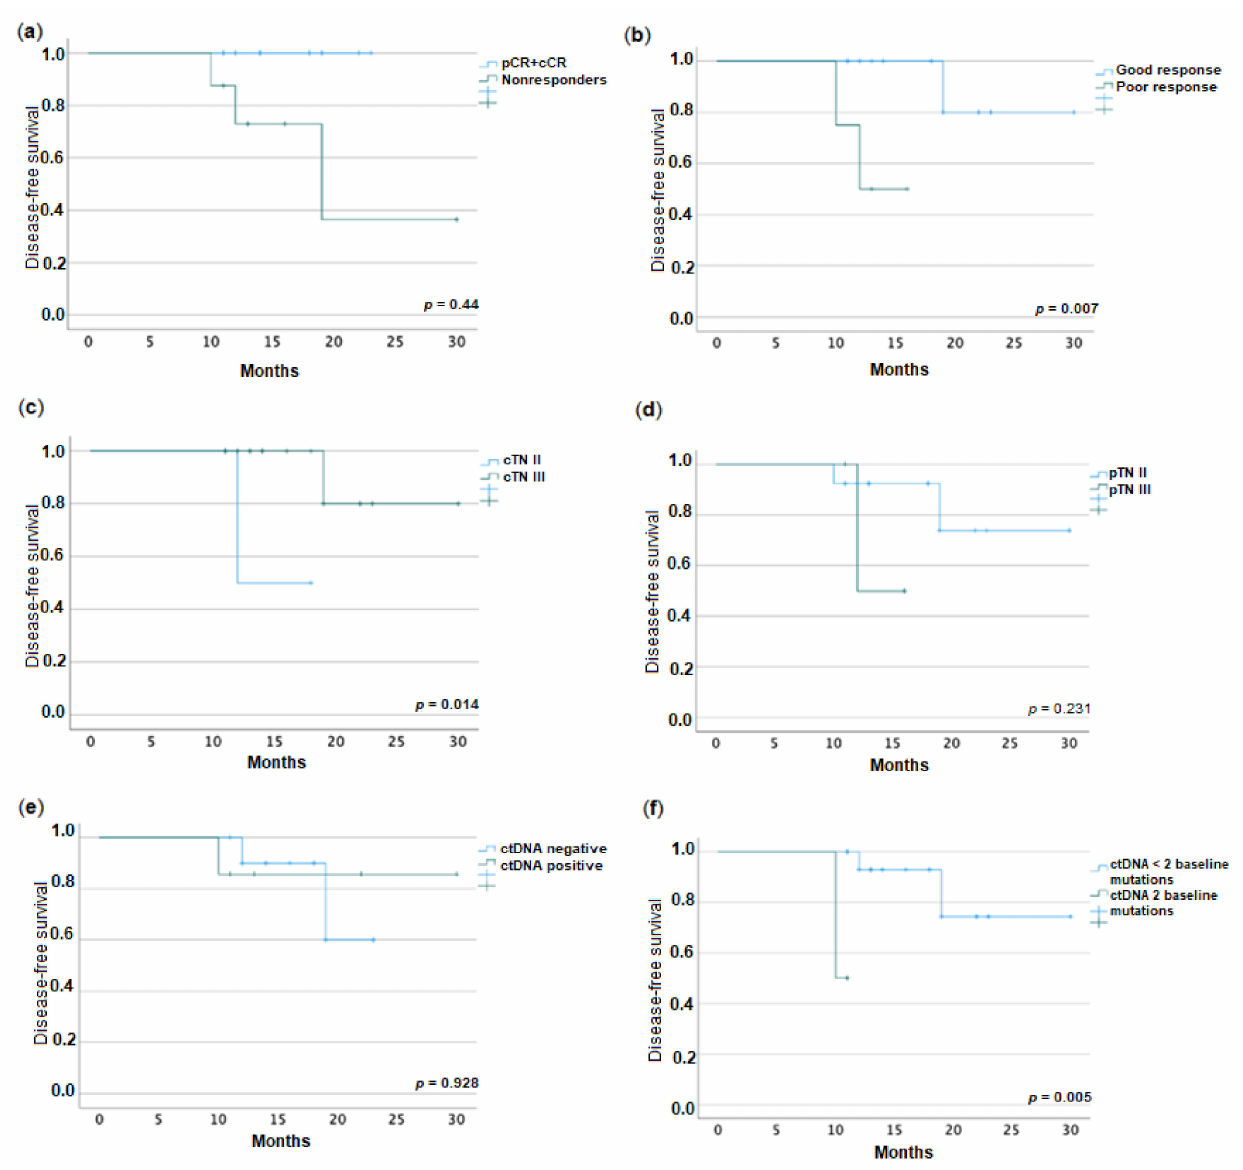
Figure 4. Kaplan–Meier curves of disease-free survival. ( a ) Responders vs. nonresponders; ( b ) Good response vs. poor response; ( c ) Clinical TN stage II vs. III; ( d ) Pathological TN stage II vs. III; ( e ) ctDNA negative vs. positive; ( f ) ctDNA baseline mutations <2 vs.